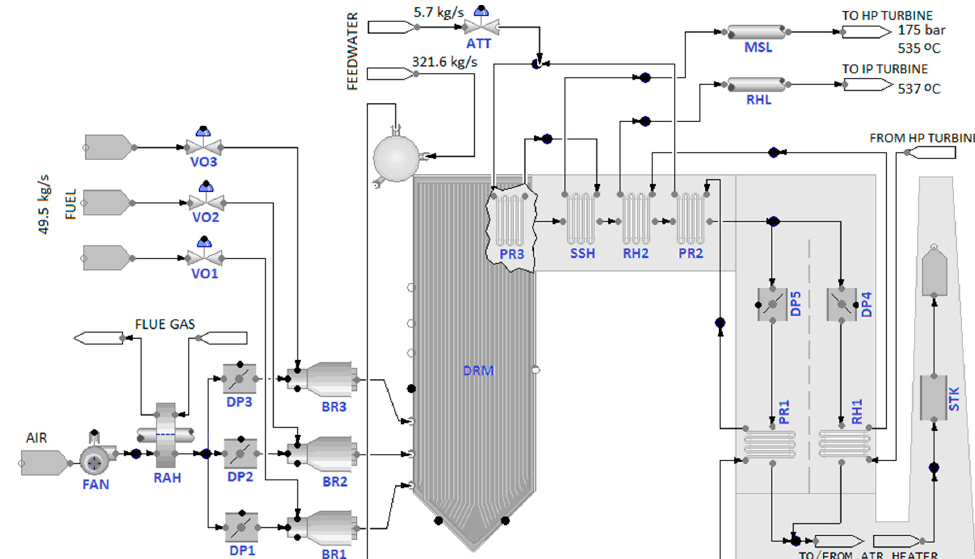
Figure 2. Boiler model implemented in ProTRAX v7.2 software environment, where, VO1–VO3: fuel